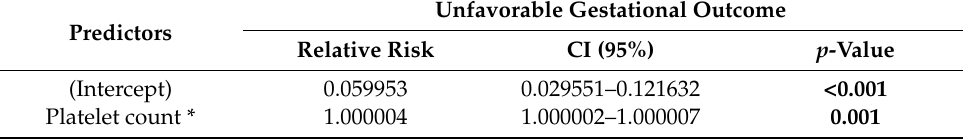
Table 4. Relative risk for unfavorable gestational outcome pregnant women with exanthematic manifestations who sought care at the Foundation of Tropical Medicine Doctor Heitor Vieira Dourado, Manaus,